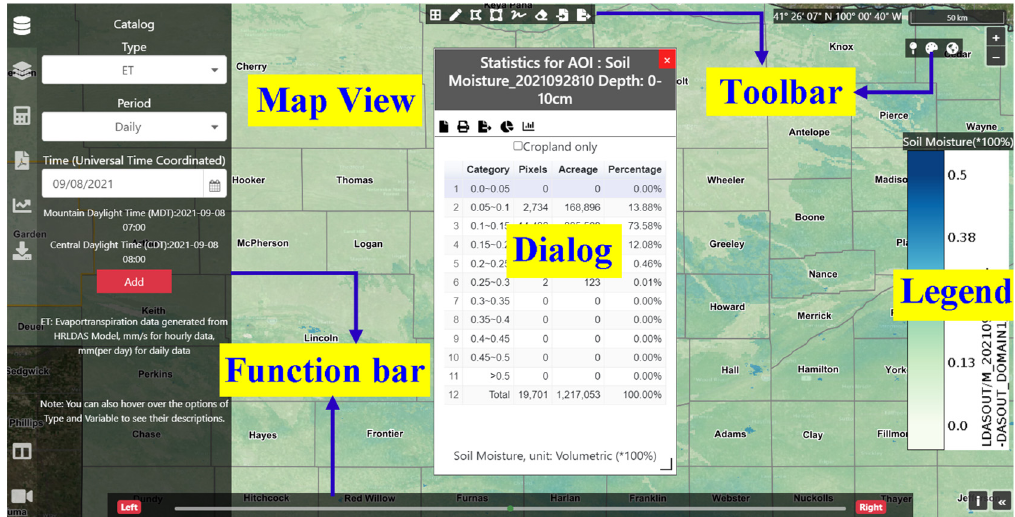
Figure 2. WaterSmart-GIS web